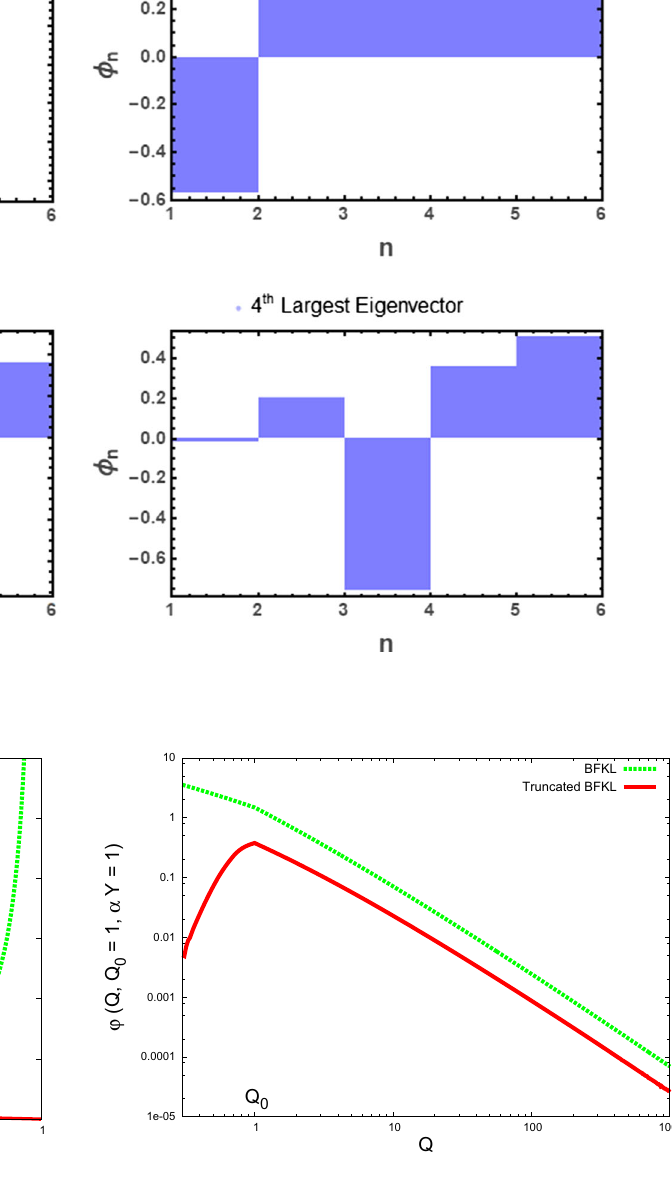
into infrared and ultraviolet regions of virtuality space. It has been found that the square truncation of the semi-infinite matrix in the BFKL equation and the action of the s = − 1 XXX spin chain Hamiltonian on a symmetric double copy of the harmonic oscillator share many common features. It was possible to make this connection by taking the origi- nal BFKL equation to its forward limit and averaging over the azimuthal angle dependence of its kernel. The remain-